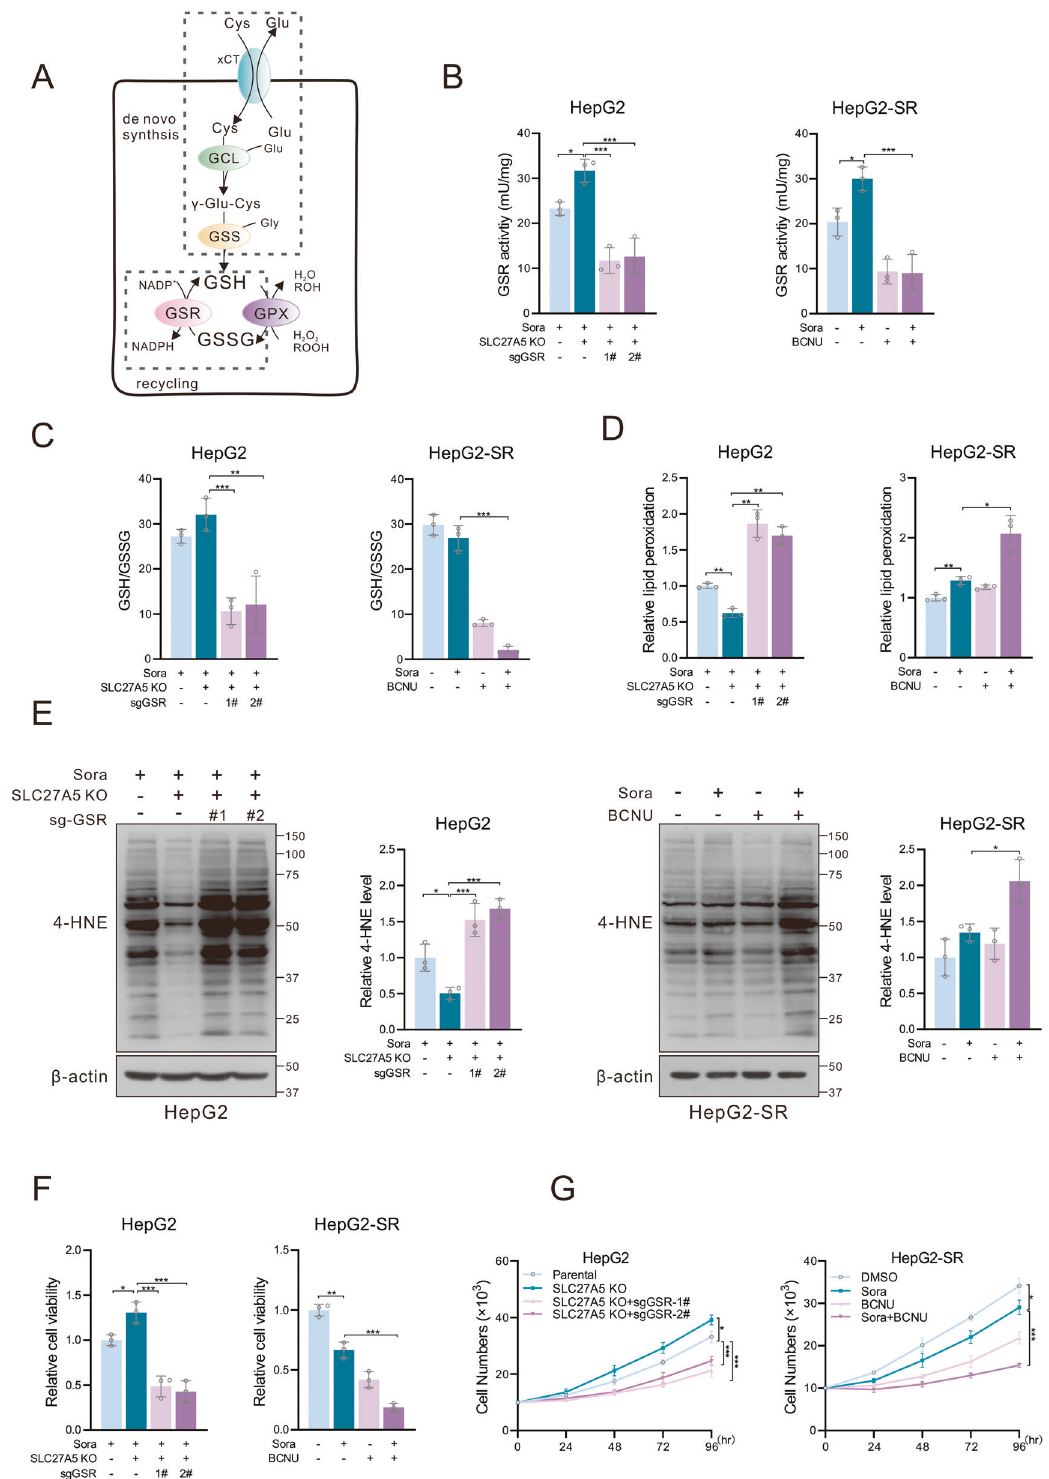
Fig. 6 Silencing the expression of GSR sensitizes HCC cells to sorafenib. A Schematic diagram summarizing the de novo synthesis and recycling of GSH. B The enzyme activity of GSR in HepG2 transfected with sg GSR (left) and HepG2-SR treated with sorafenib or/and BCNU (right). C – E Relative level of GSH/GSSG ratio ( C ), lipid peroxidation ( D ), and the 4-HNE-induced protein modi fi cation ( E ) in SLC27A5-KO HepG2 transfected with sg GSR (left) and HepG2-SR treated with sorafenib or/and BCNU (right). F , G Relative cell viability ( F ) and cell growth curve ( G ) of SLC27A5-KO HepG2 transfected with sg GSR (left) and HepG2-SR treated with sorafenib or/and BCNU (right). Cys cystine, Glu glutamate, Gly glycine, BCNU carmustine. Data shown are mean ± SD ( n = 3). Statistical signi fi cance was calculated using one-way ANOVA test. * p < 0.05, ** p < 0.01 *** p < 0.001.